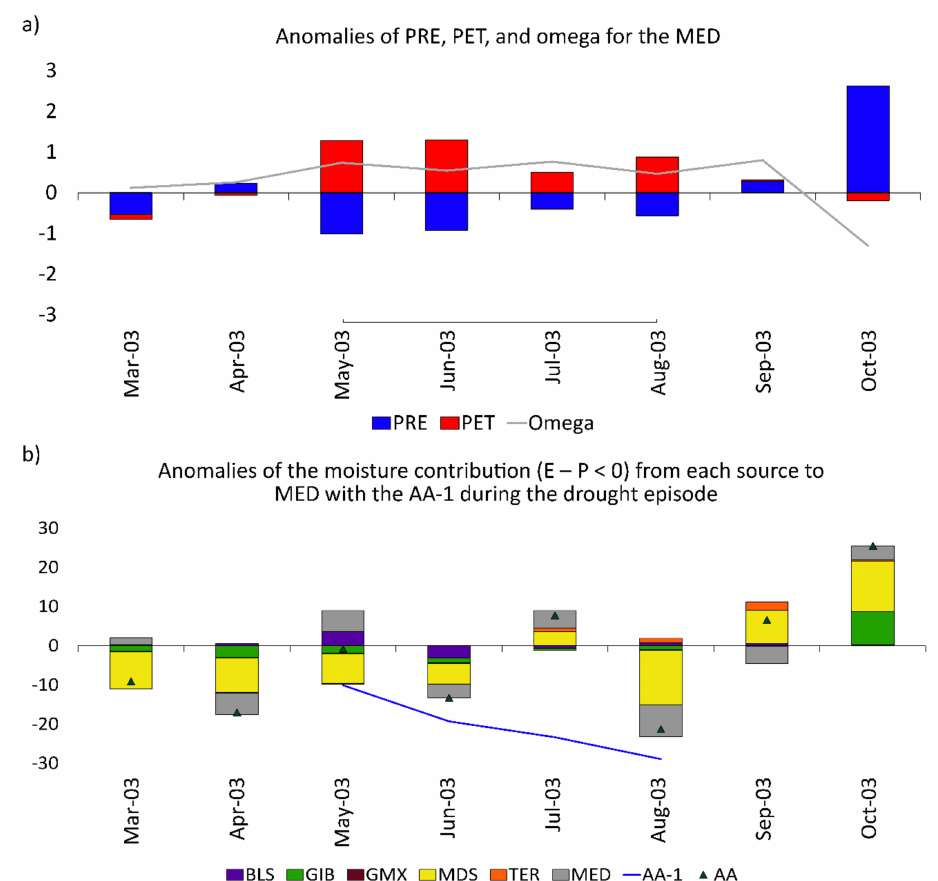
Figure 8. ( a ) Monthly anomalies of the precipitation (PRE, /10 mm/month), potential evapotranspiration (PET, /10 mm/month) (data from Climatic Research Unit (CRU) Time-Series (TS) 3.24.01), and average ERA-Interim pressure velocity at 500 hPa over the Mediterranean region; and ( b ) Anomalies in the moisture supply (E − P < 0) from each source over the Mediterranean region, obtained via the forward in time experiment (mm/day) with the accumulated anomaly of the supply from all of the sources (AA, mm/day) and the accumulated precipitation anomalies (data from CRU TS 3.24.01) (AA-1, mm/month) for the episode from May to August 2003. Table 5. Anomalies of the moisture supply from the sources to the Mediterranean region accumulated during the drought episode from May to August 2003 (mm/day). Gibraltar (GIB); Gulf of Mexico (GMX). BLS GIB GMX MDS TER MED 0.66 − 4.82 − 0.27 − 23.29 1.82 −